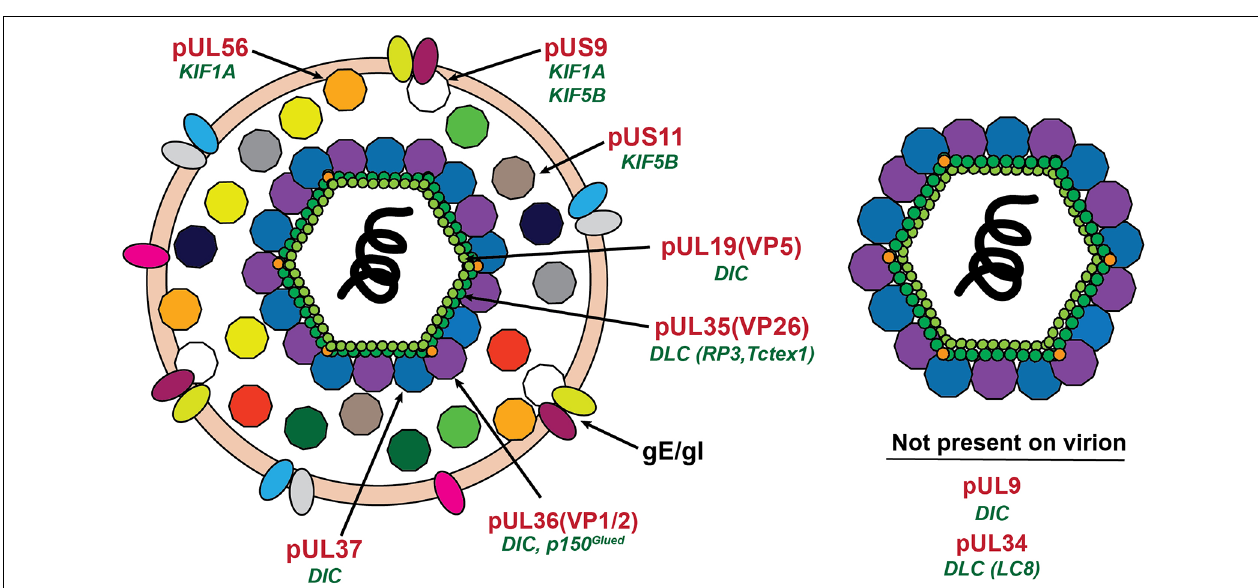
FIGURE 3 | Location of proposed motor binding proteins in the alphaherpesvirus virion. The mature extracellular virion is shown on the left. The post-fusion (see Figure 2C ) virion is shown on the right. Proteins with reported interactions with microtubule motor proteins are labeled in red with the motor protein subunit listed in green